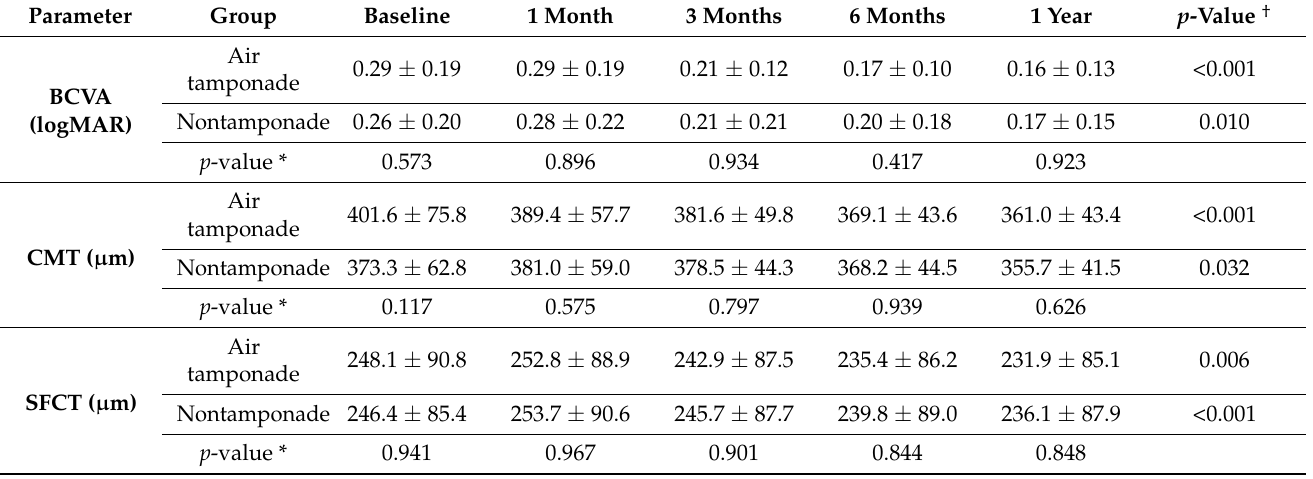
Table 2. Comparison of the parameters of the air tamponade and nontamponade groups over 1